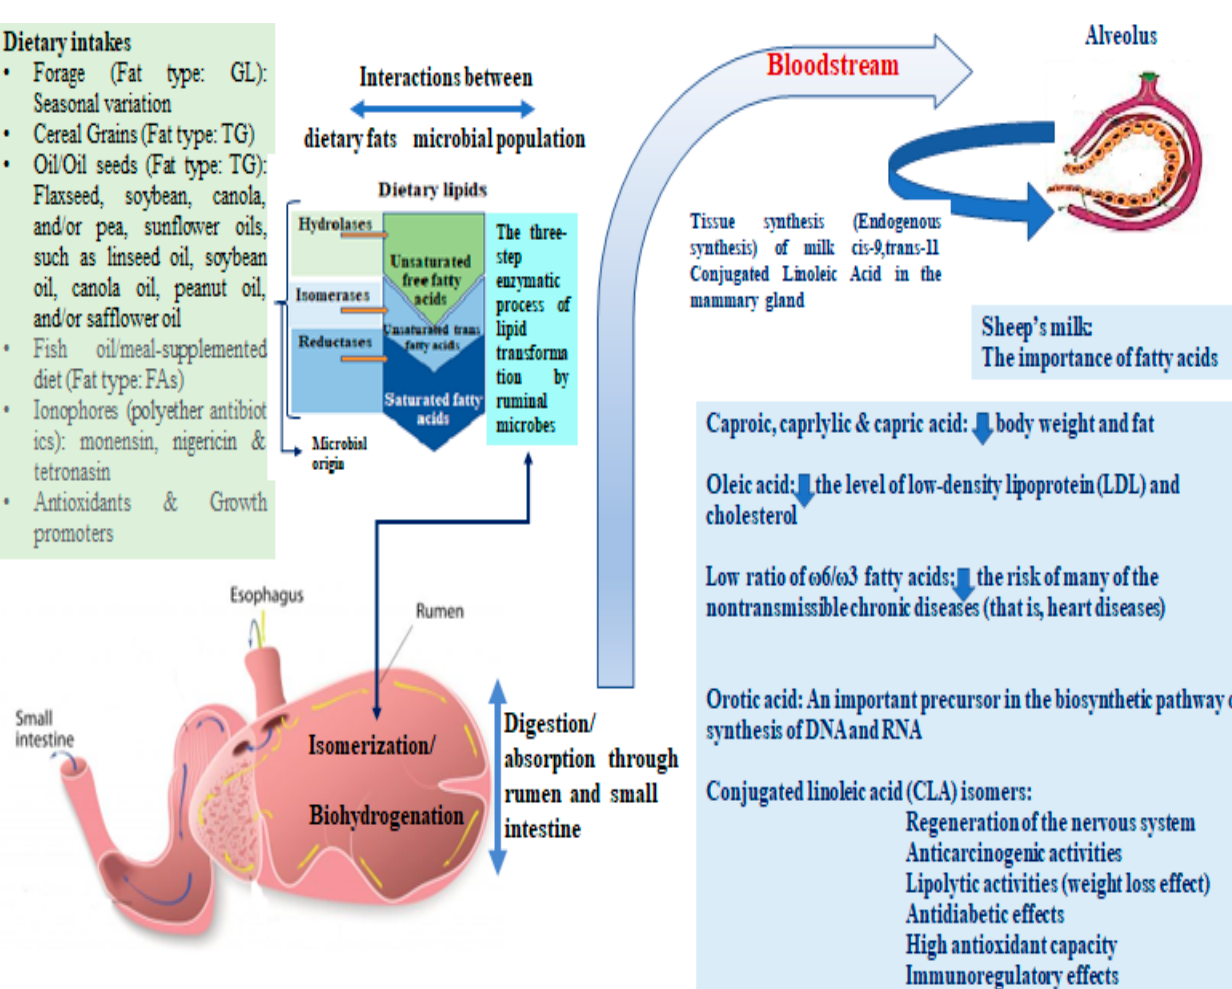
Figure 1. Sheep’s milk; Diagram of the dietary factors affecting ruminant fats, the three enzymatic steps of lipid transformation by ruminal microbes, the biosynthesis FA, and the importance of FAs to human health. TG: Triacylglycerides; GL: Glycolipids; FAs: Fatty acids .